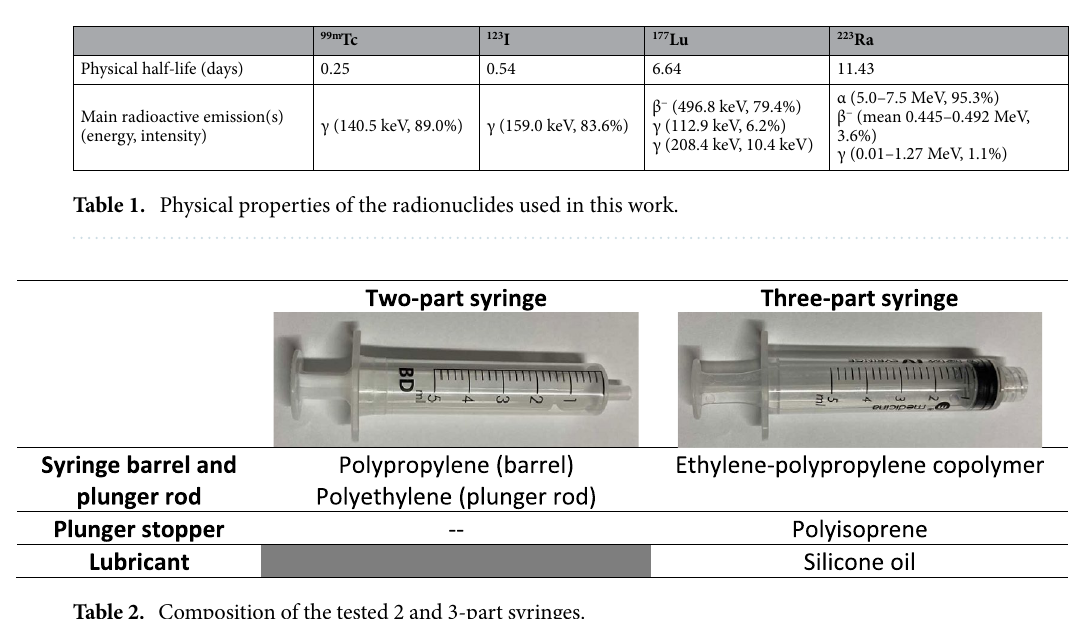
Table 2. Composition of the tested 2 and 3-part